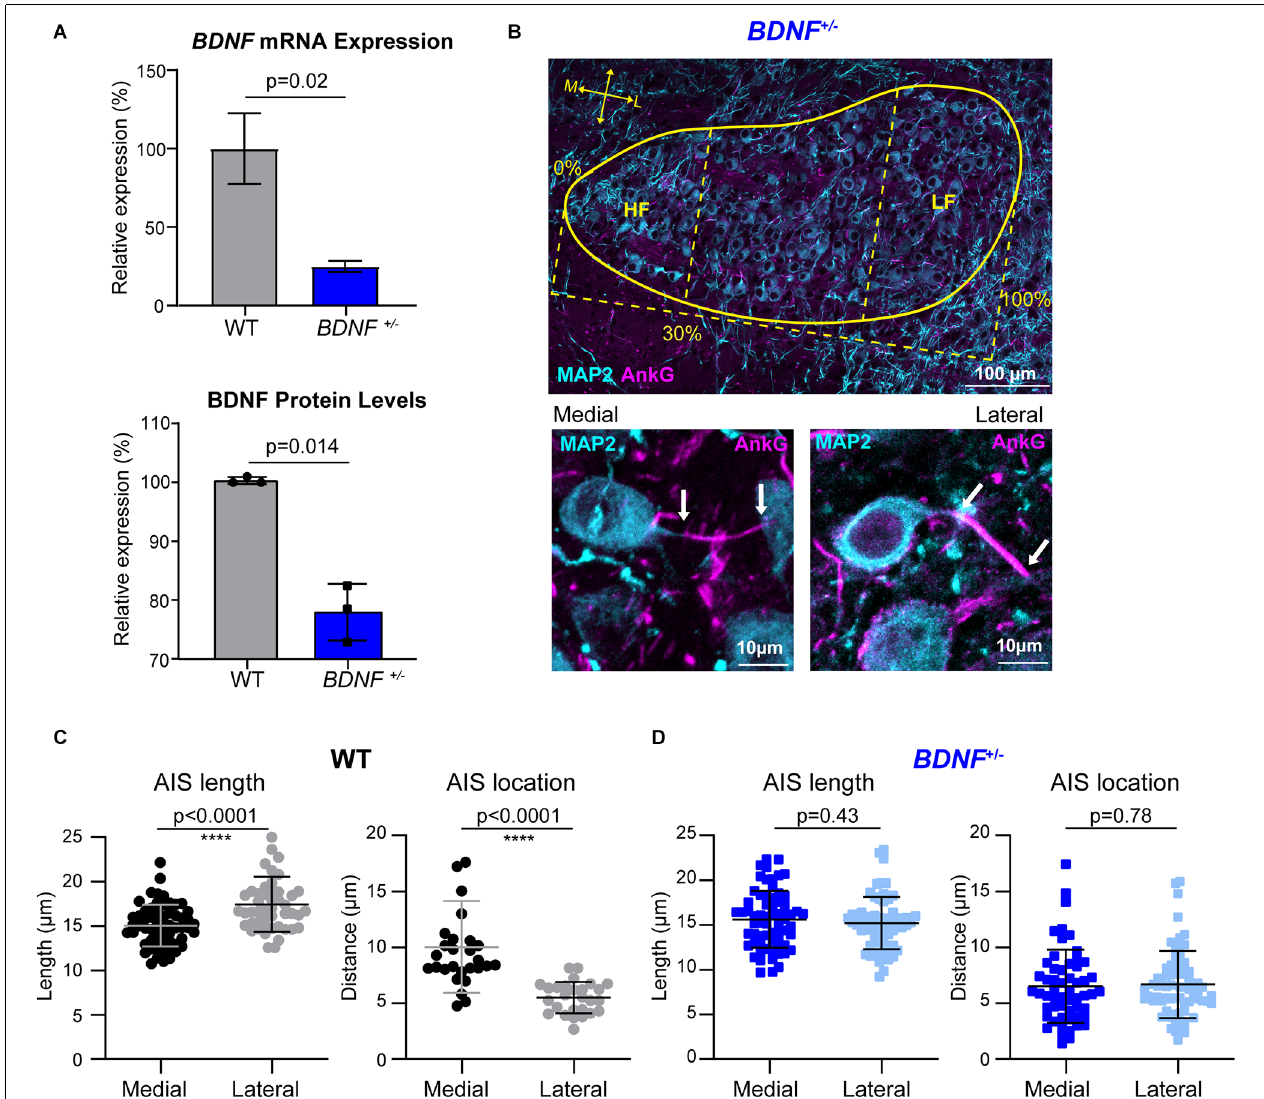
FIGURE 1 | The tonotopic arrangement of the AIS in MNTB neurons is abolished in BDNF + / − mice. (A) BDNF mRNA expression (top) and BDNF protein level (bottom) in the MNTB from WT and BDNF + / − mice using qPCR and Western Blot, respectively. BDNF mRNA expression and protein level from BDNF + / − mice were normalized by those from WT (indicated by Relative expression, %). (B) The MNTB (at P20, the yellow line indicates border) was immunostained with MAP2 (cyan) and AnkG (magenta). HF indicates the high-frequency responding region, 30% of the medial (M) MNTB, and LF indicates the low-frequency responding region, 30% of the lateral (L) MNTB. (Bottom) Magnified images of medial and lateral MNTB neurons of BDNF + / − mice. Arrows indicate the proximal and distal ends of AIS. (C) Summary of length ( µ m) and location (distance from the soma) of the AIS in WT MNTB neurons. (D) AIS length and distance from soma from BDNF + / − medial and lateral neurons. Each point represents individual cells from three WT mice and four BDNF + / − mice. All error bars represent mean ± SD. **** indicates p <